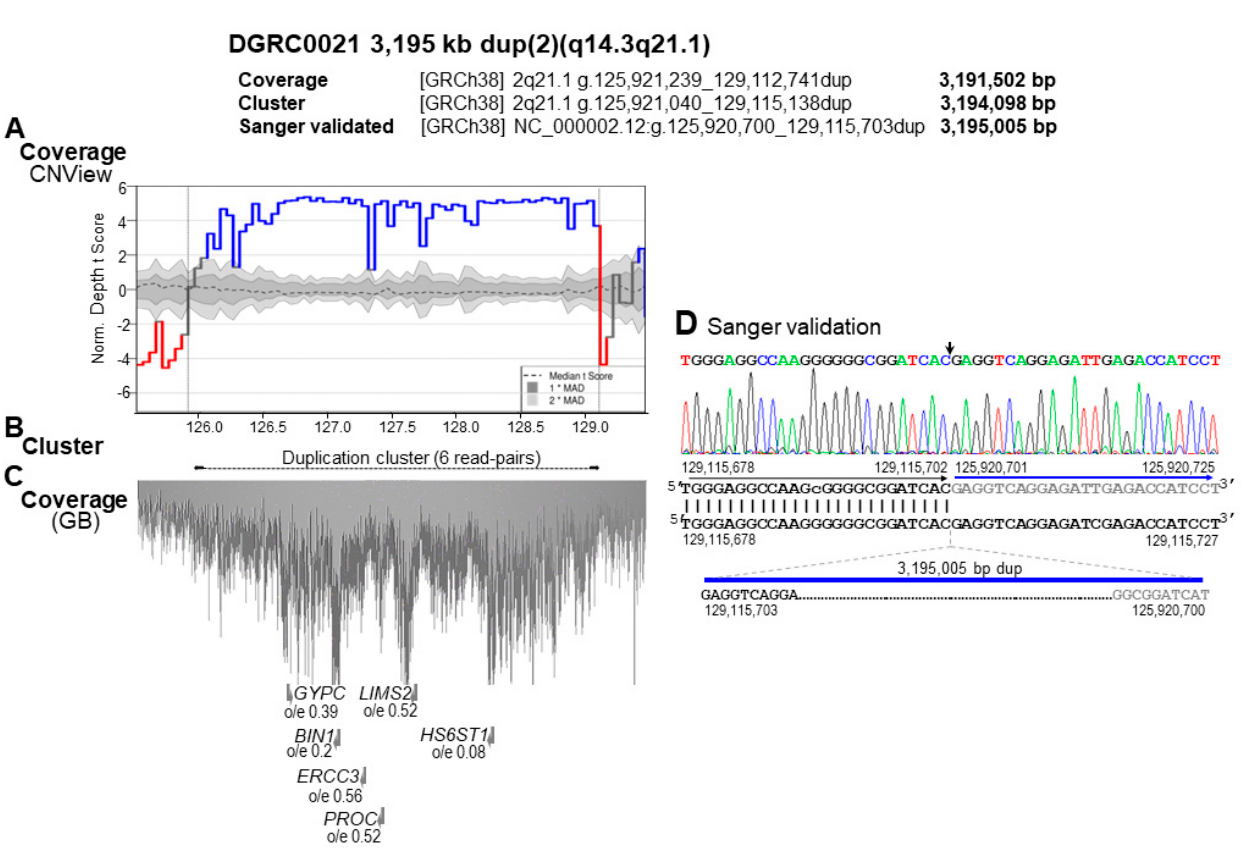
Figure 2. Illustration of the proband-specific dup(2)(2q14.3q21.1) of 3195 kb by genome coverage, read-pair cluster and SS. The size of the duplication varies according to the detection method and is indicated above. ( A ) Genomic coverage plot generated by CNView showing the 3,191,502 bp dupli- cation. The horizontal black dashed line with darker and lighter gray shading indicates median cov- erage and deviation, respectively. Regions with a statistically significant increase in sequence cov- erage ( α = 0.05, Bonferroni correction) indicating duplications are depicted in blue. ( B ) Arrows joined by a dashed line indicate the location and orientation of the read − pairs cluster identifying the 3194 kb dup, with respect to the human physical genome map and genome coverage of this region. ( C ) A picture from the genome browser illustrating the coverage of this region by sequencing read − pairs. Each dot represents genomic location of a sequence read. Below, folded gray arrows indicate the position of OMIM genes in sense and antisense orientations. Their LoF intolerance score, expressed as the o/e ratio of LoF variants, is stated below each gene. ( D ) Nucleotide sequence of the 3,195,004 bp dup(2)(q14.3q21.1) junction fragment aligned against the GRCh38 reference hu- man genome. The downstream and upstream sequences at the duplication breakpoint are in black and gray, respectively. Vertical lines indicate identical nucleotides between the aligned sequences. 3.3. Identification of Additional Genetic Defects As the pathogenic effect of the identified genomic variants was unclear and no addi- tional, potentially pathogenic CNV could be identified, ES was performed, with an aver- age coverage of 125×. This analysis revealed a novel variant in exon 30 of the Chromo- domain helicase DNA binding protein 4 ( CHD4 , OMIM *603277, NM_001273.5), NC_000002.12:g.6,582,210del; c.4442delG, p.(Gly1481Valfs*21). Afterwards, as an inde- pendent assay replacing Sanger sequencing, the frameshift variant was confirmed in the liGS data; however, due to low sequence coverage of liGS, this frameshift single-nucleo- tide deletion was identified only in a single GS read (Figure 3). This variant is within a